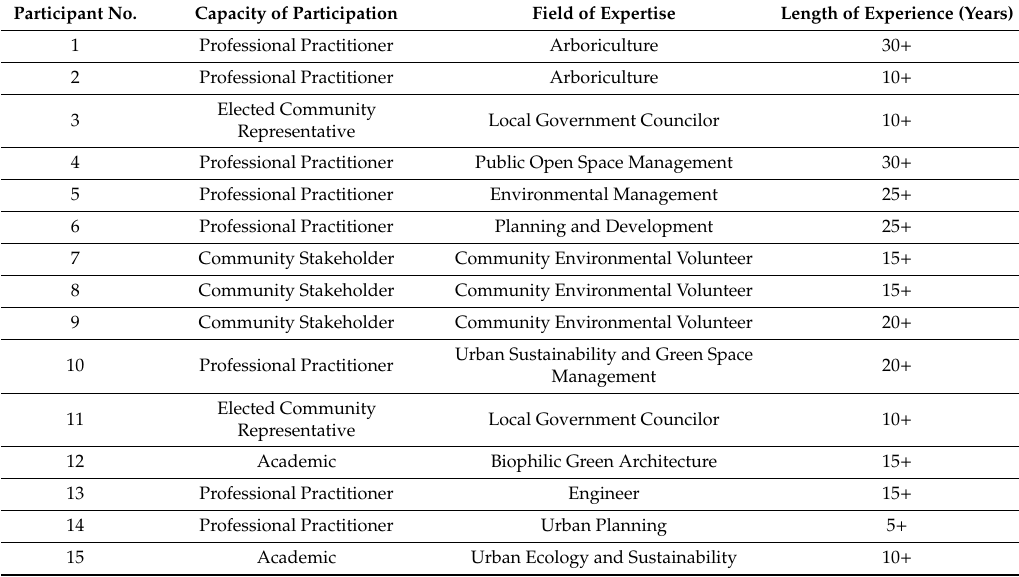
Table 1. Focus group participant